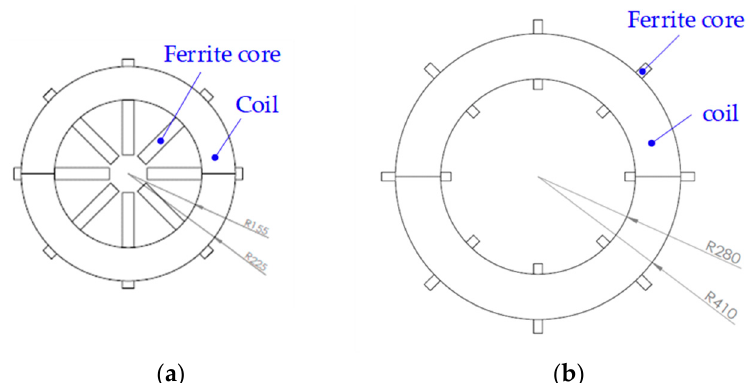
Figure 11. Two-coil system specifications and configurations. ( a ) Rx coil; ( b ) Tx coil.